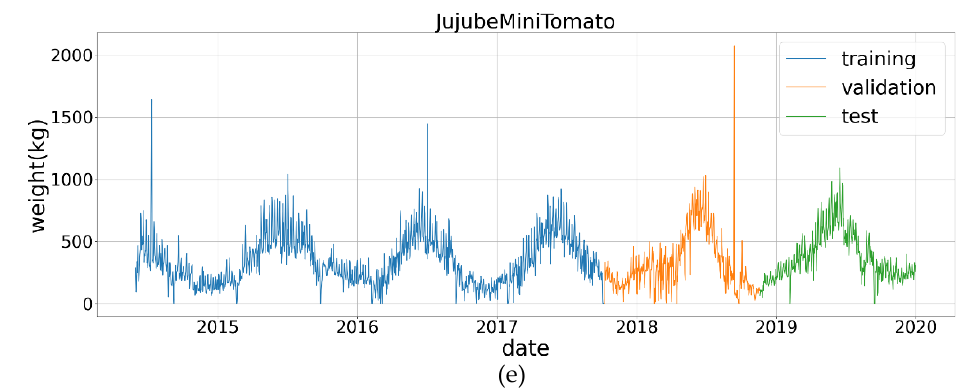
Figure 1. Sales volumes of five items (WelshOnion ( a ), Lettuce ( b ), ChineseMallow ( c ), Onion ( d ), and JujubeMiniTomato ( e )). Note that the y-axis scale of each plot is different. The first 60% was used for the training subset (blue line), the next 20% was used for the validation subset (orange line), and the most recent 20% was used for the test subset (green line).